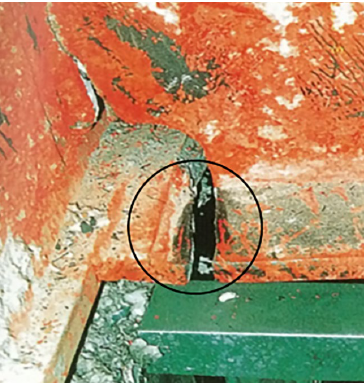
Figure 2. Fracture at beam-column-connection of the steel structure damaged by Kobe earthquake in 1995